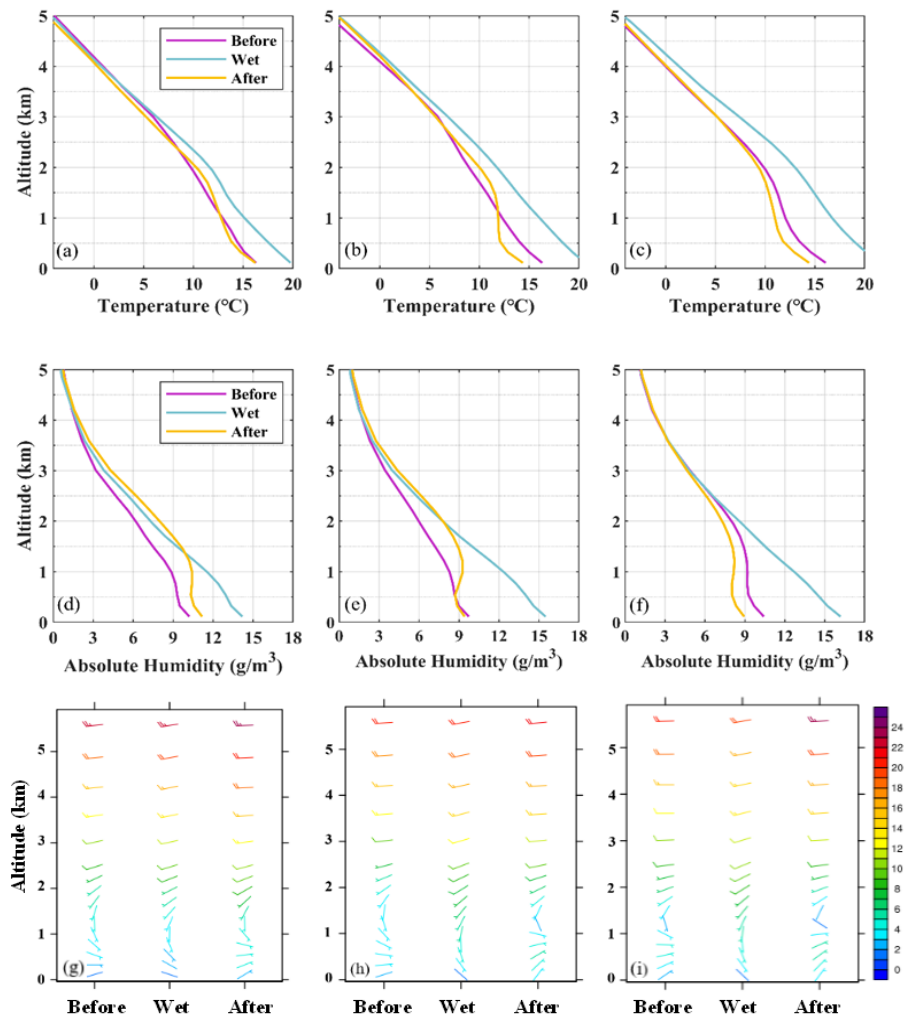
Figure 4. The average profile of meteorological elements under different stages and levels in February and March from 2012 to 2021. ( a , d , g ) Slight humidity, ( b , e , h ) moderate humidity, and ( c , f , i ) heavy humidity. ( a – c ) Temperature ( ◦ C), ( d – f ) absolute humidity (g/m 3 ), and ( g – i ) wind direction and wind speed (m/s).